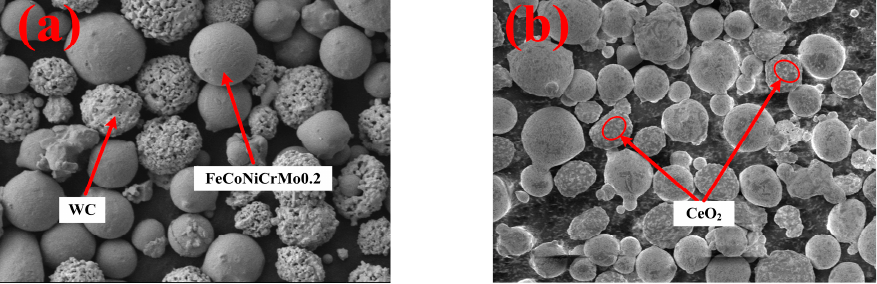
Figure 2. The morphology of the two composite powders: ( a ) FeCoNiCrMo0.2 + WC powder; ( b ) FeCoNiCrMo0.2 + WC + CeO 2 powder.